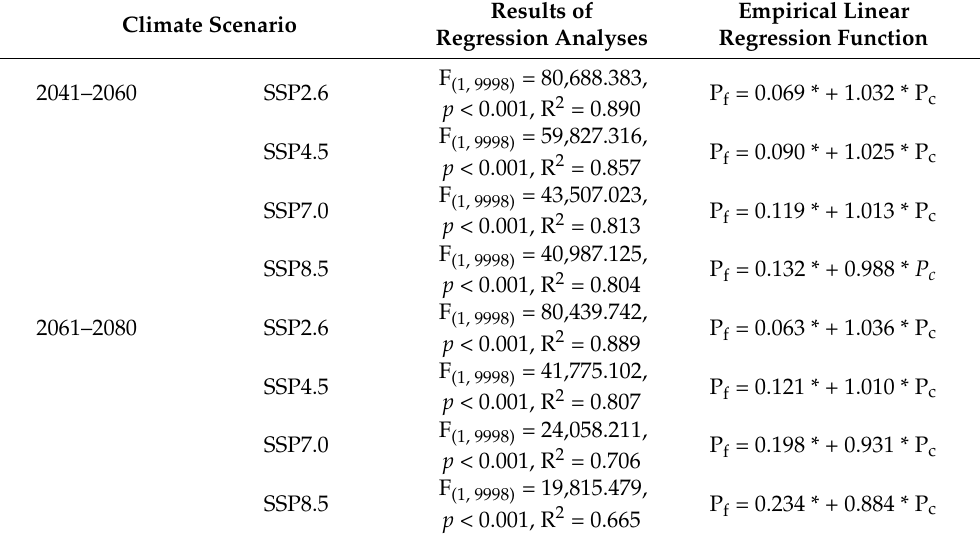
Table 3. Result of the regression analyses conducted between current and future occurrence proba- bilities of buffelgrass across Mexico. Future occurrence probabilities were estimated by projecting the CNM on the current climate and the climate change scenarios predicted by CanESM5 on 20-year intervals considering the radiative forcing associated with the different SSPs. The table also provides the linear regression function that resulted from these analyses, where P f is the future occurrence probability of the species and P c is the current occurrence probability of the